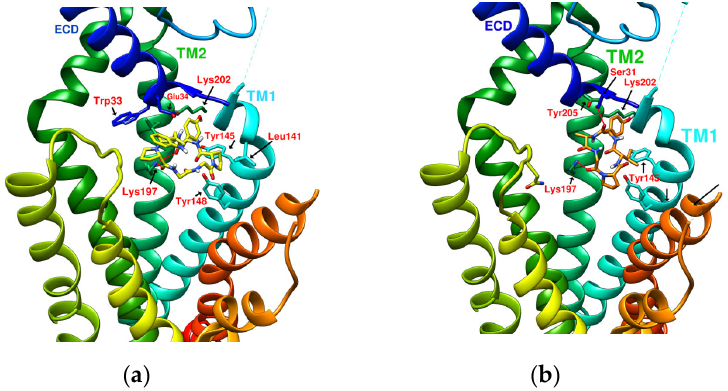
Figure 4. ( a ) DdC/GLP-1R (−11.9 kcal/mol), ( b ) HJ/GLP-1R (−9.7 kcal/mol).